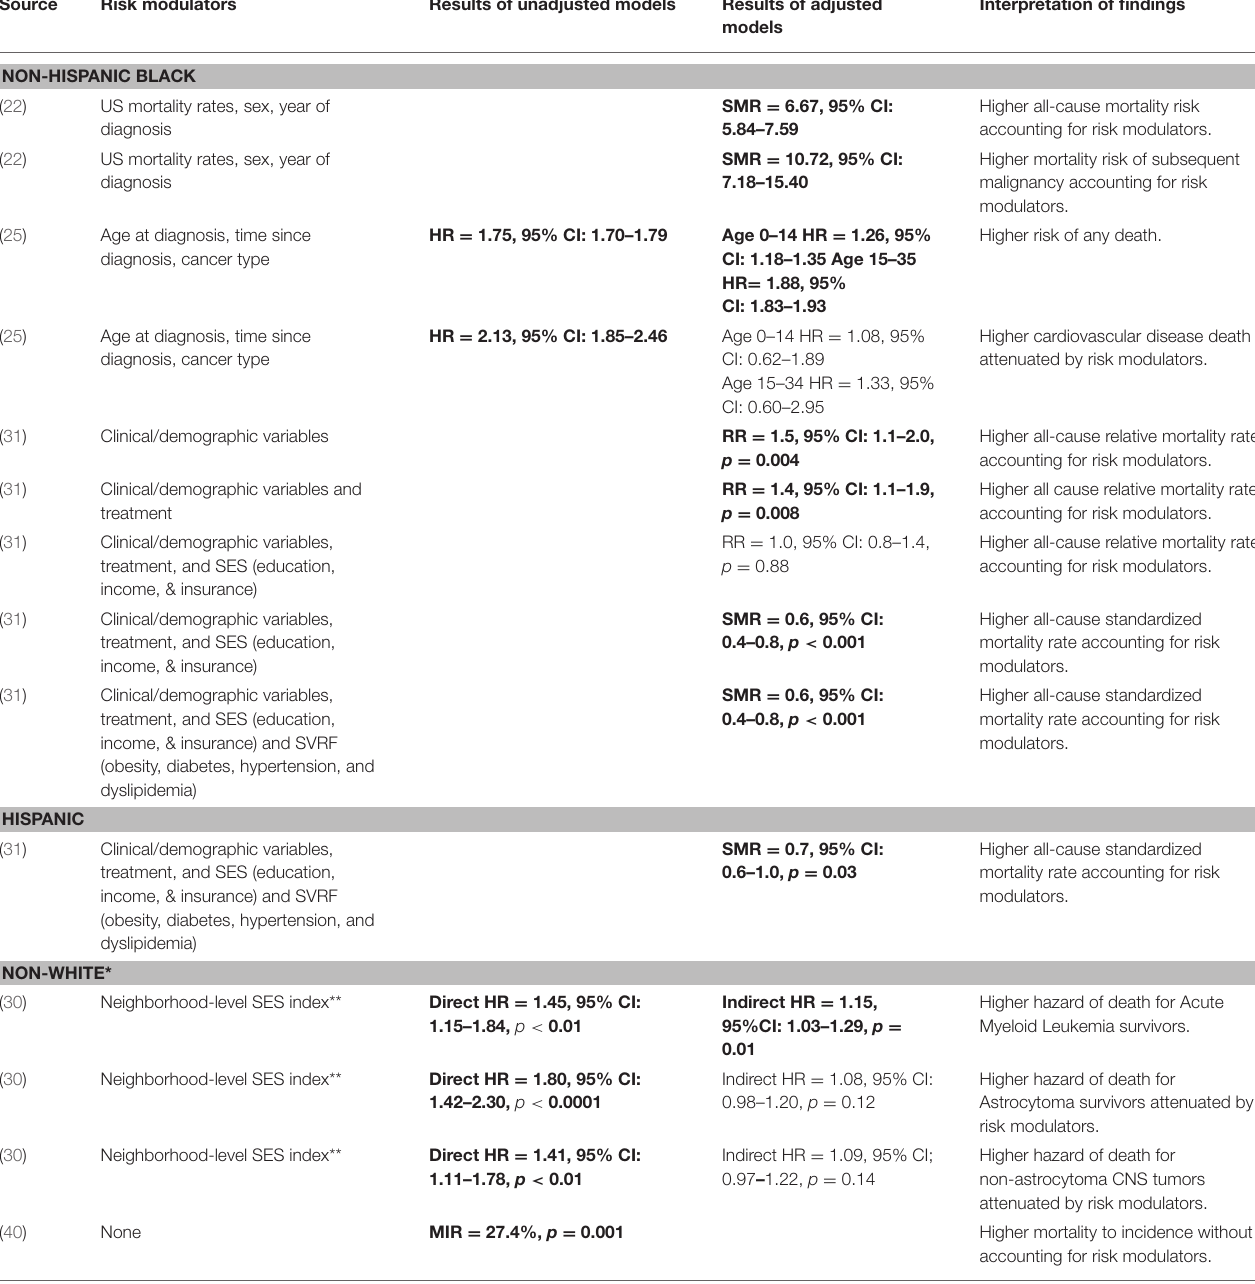
TABLE 5 | Factors influencing disparities in survival for childhood cancer survivors by